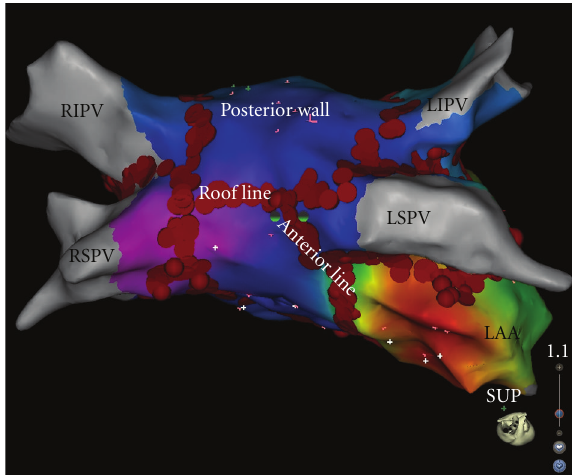
Figure 3: Three-dimensional reconstruction of the left atrium using the CARTO 3 map system (Biosence Webster, USA) showing large circumferential ablation lesions around both ipsilateral veins along with roof and anterior lines. LAA: left atrial appendage; LSPV: left superior pulmonary vein; LIPV: left inferior pulmonary vein; RSPV: right superior pulmonary vein; RIPV: right inferior pulmonary